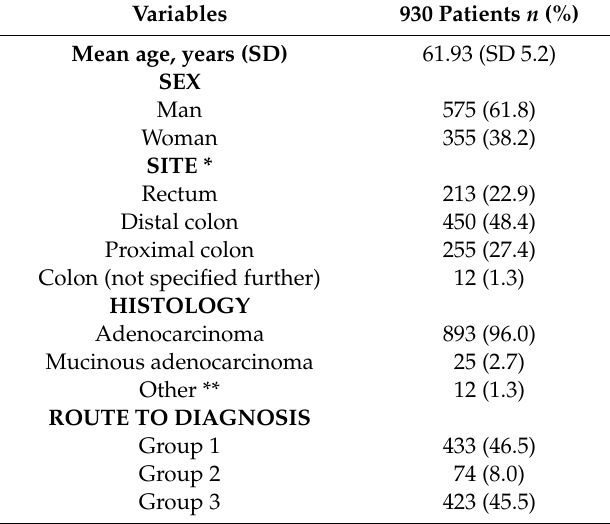
Table 1. Descriptive data on cases of colorectal cancer